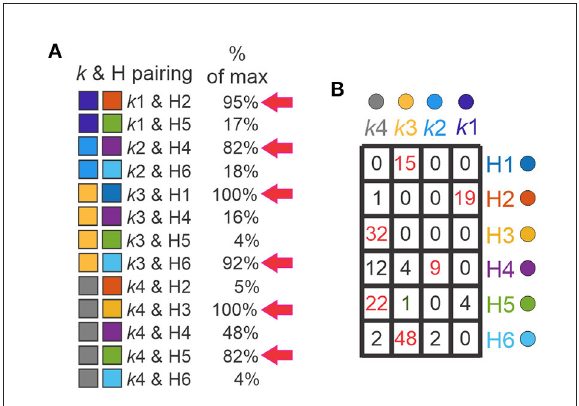
FIGURE7 Comparison between k and H clusters. (A) Thirteen possible combinations between k -cluster and H-clusters (k & H pairing, left) with the corresponding maximum percentage of appearance (right). The pairings with percentages higher than 80% are marked with red arrows. k -clusters (left boxes), k1 (purple), k 2 (blue), k 3 (yellow), k 4 (gray), H-clusters (right boxes), H1 (blue), H2 (orange), H3 (yellow), H4 (purple), H5 (green) and H6 (cyan). (B) Table shows the k & H pairing. Numbers indicate the neurons within the corresponding cluster, k in columns and H in rows. Red numbers are the neurons with pairing with percentages higher than